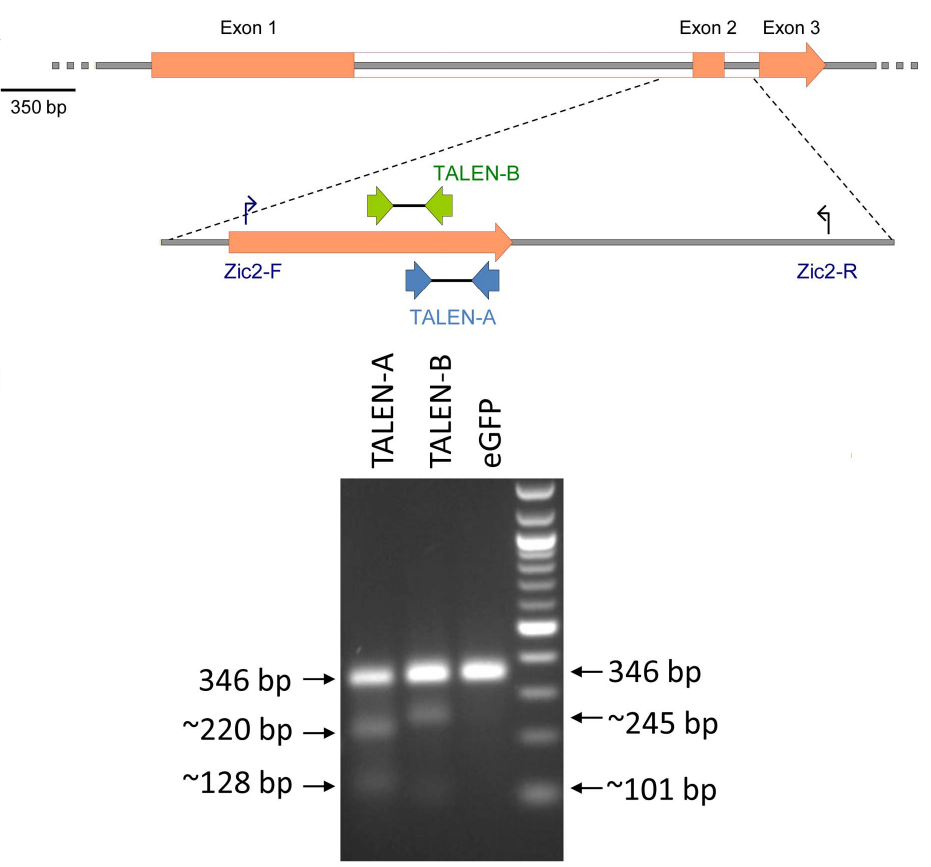
Figure 1. Zic2 genomic structure and TALEN binding sites. A) Genomic structure of the murine Zic2 (upper panel) with an enlargement of exon 2 (lower panel), showing the binding sites of the two monomers for TALEN-A and TALEN-B together with the binding sites of the PCR primers, Zic2-F and Zic2-R used to genotype the mutant alleles. B) Example of the Cel1 endonuclease assay showing cleavage of the PCR amplicon from example heterozygous mutant CD1 embryos, injected with TALEN-A mRNAs, TALEN-B mRNAs and control eGFP mRNA. The fragments obtained correspond to the predicted cleavage of the 346 bp amplicon within the spacer region of the TALEN-A and TALEN-B recognition sites as expected.